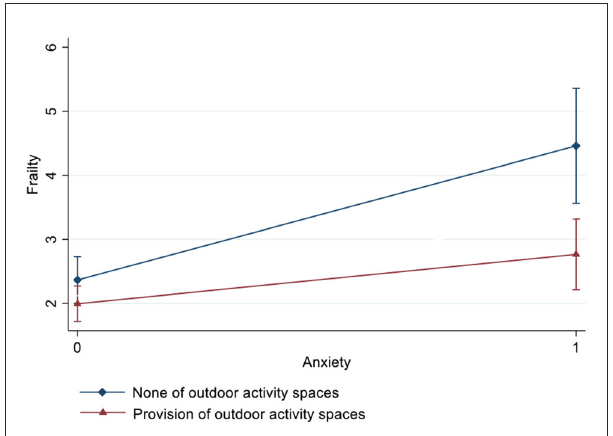
FIGURE4 Interaction effect of anxiety and outdoor activity spaces on frailty among men estimated based on a fully adjusted model (including age, years of education, marital status, economic conditions, comorbidities, cognitive impairment, loneliness, and nutritional